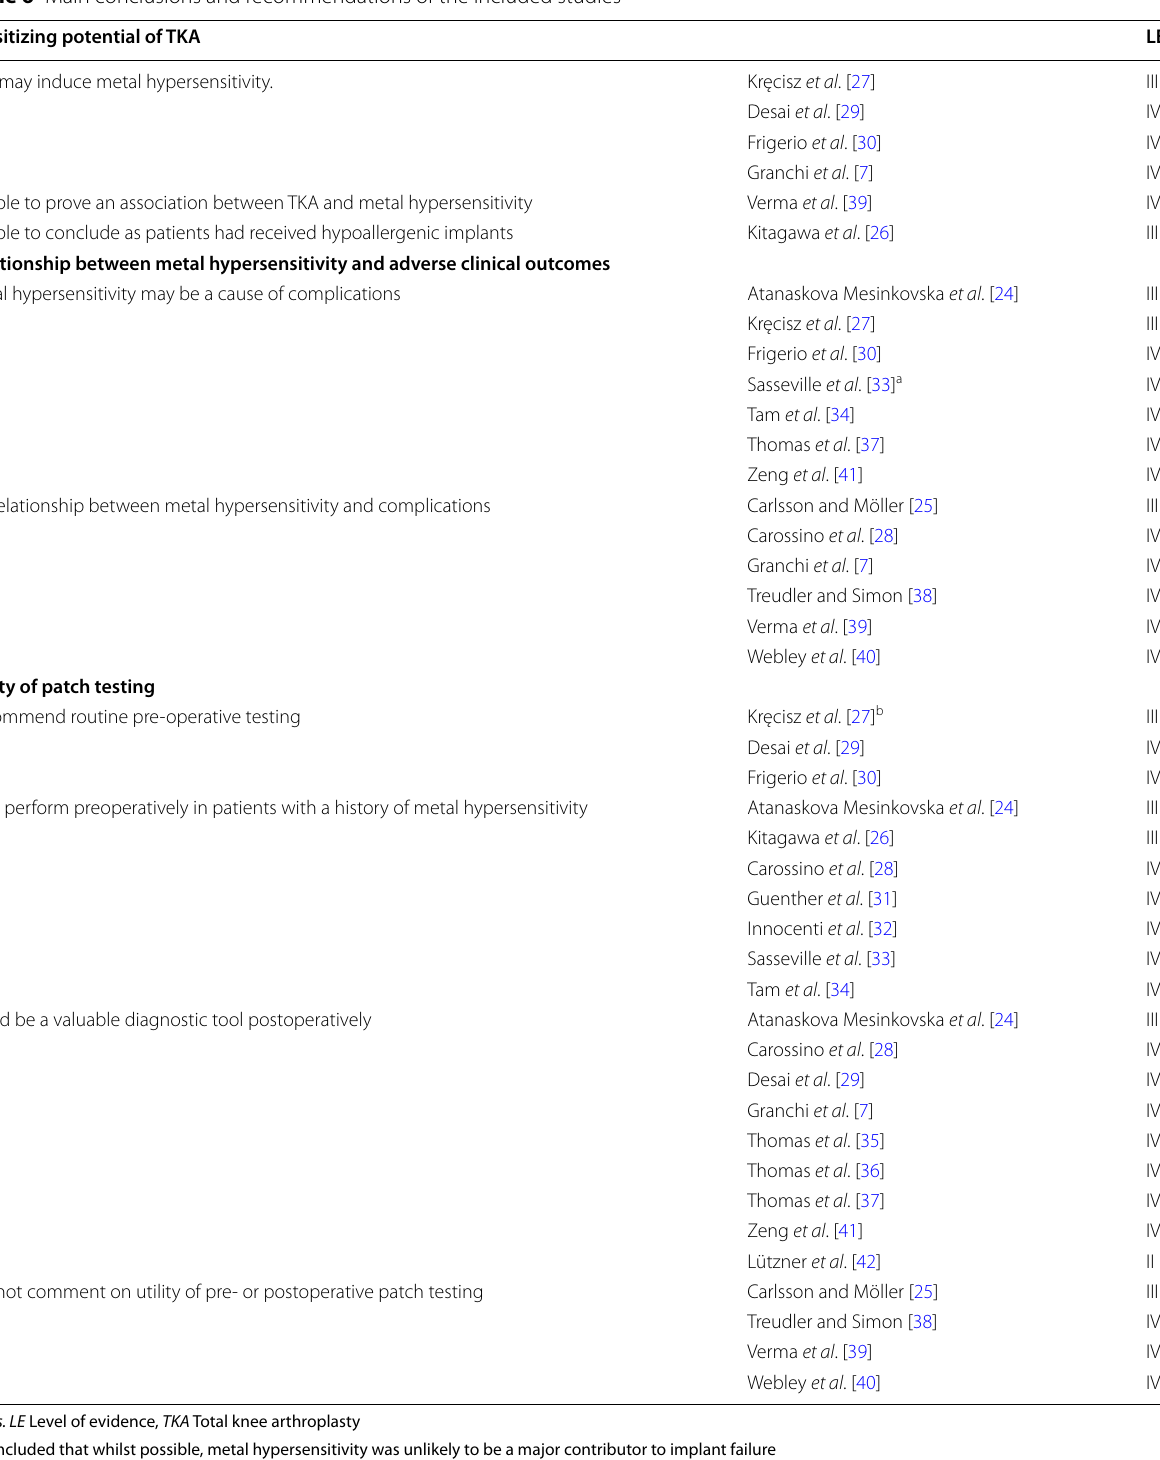
Table 6 Main conclusions and recommendations of the included